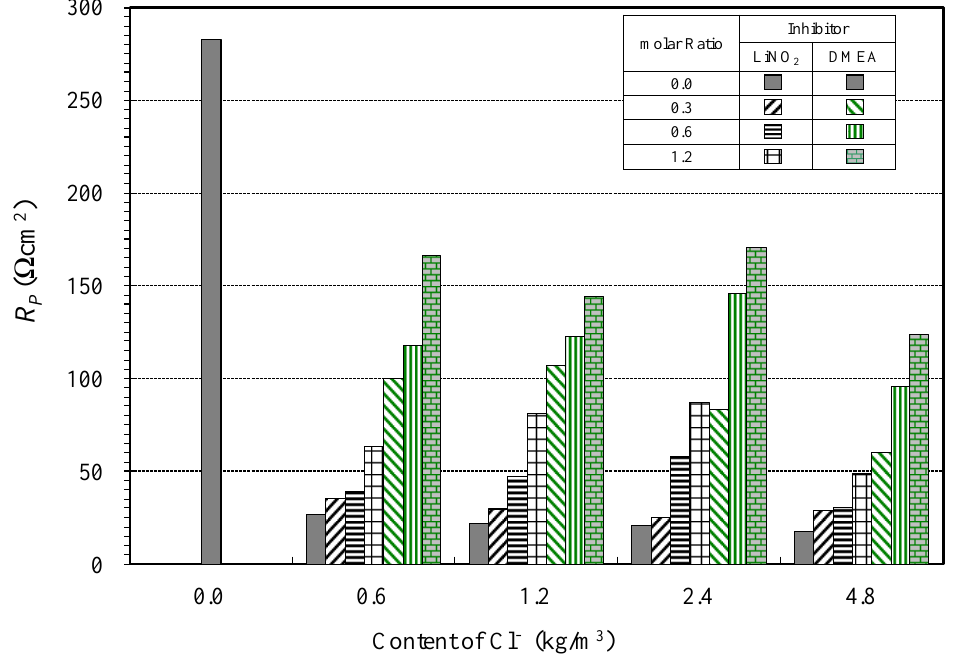
Figure 9. Relationship between polarization resistance and molar